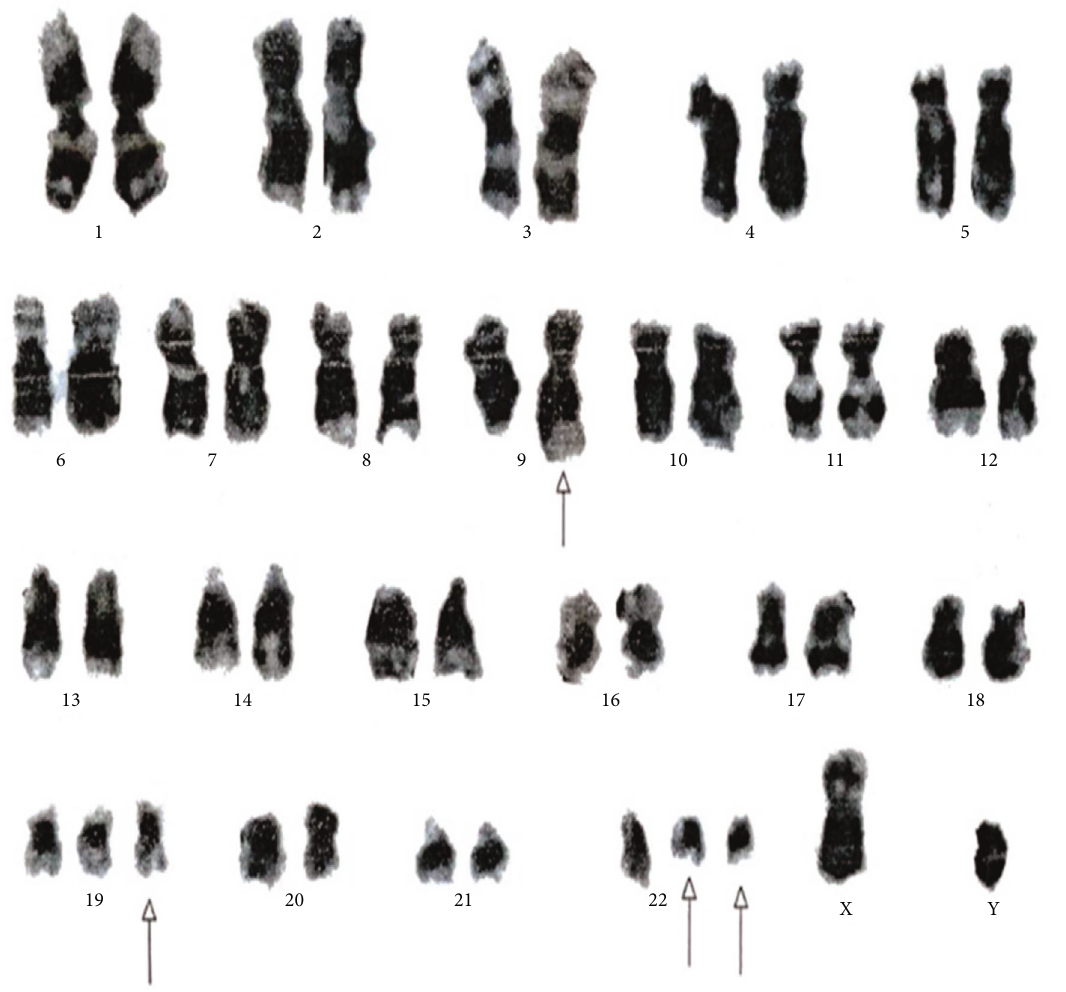
Figure 6: Cytogenetic analysis shows a rare translocation 46XY,t(9;22)(q34;q11.2)[12]/48XY,t(9;22)(q34;q11.2),+19,der(22)t(9;22)